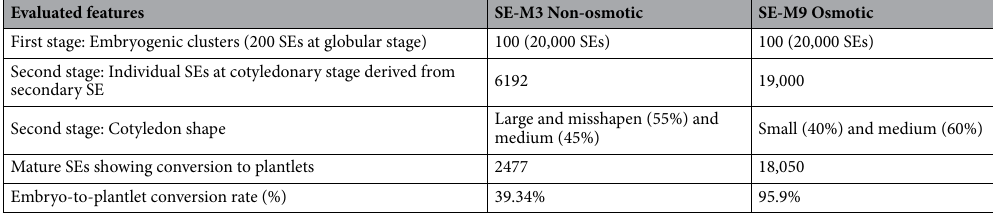
Table 1. SEs maturation efficiency of C. arabica var. Typica produced in two different treatments: SE-M3 (non-osmotic) and SE-M9 (osmotic medium).